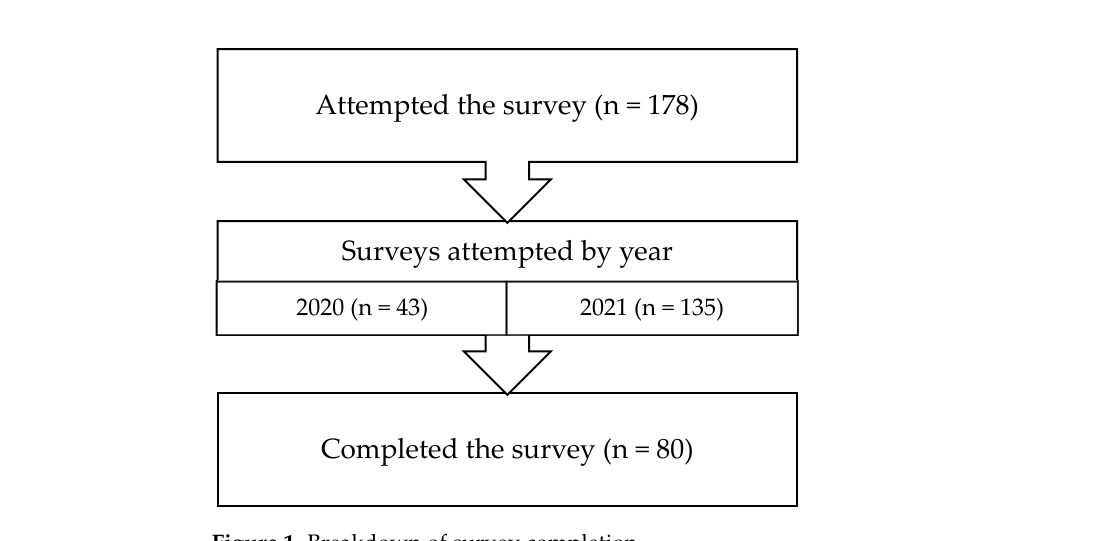
Figure 1. Breakdown of survey completion. Table 1. Survey Respondents’ Demographics.